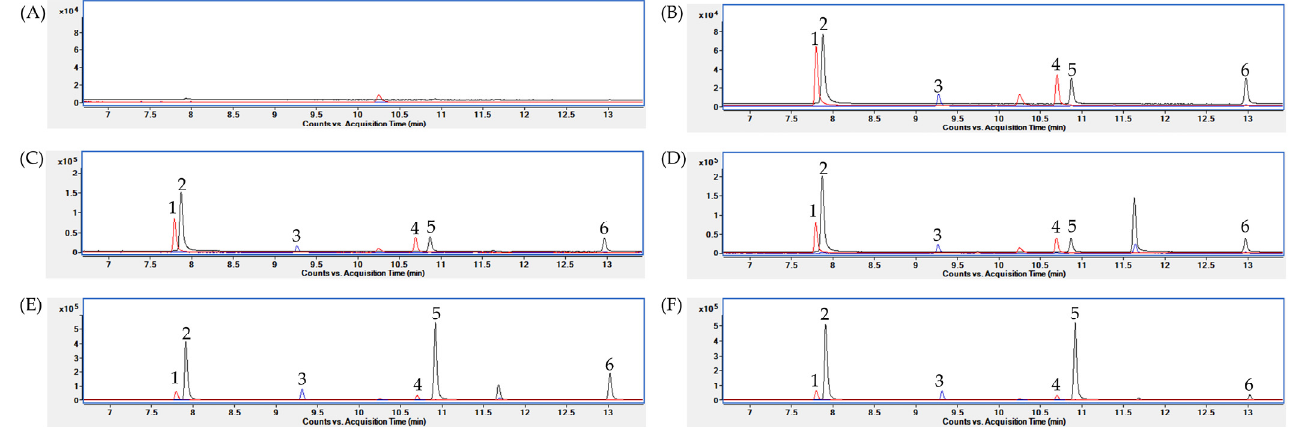
Figure 2. Aggregates of SIM chromatograms (black, m / z = 60.0; red, m / z = 63.0; blue, m / z = 74.0) of SCFAs extracted with MTBE in ( A ) blank water, ( B ) SCFA standard mixture in water, ( C ) plasma, ( D ) serum, ( E ) feces, and ( F ) mouse cecum tissue samples. Peak identification: 1, acetic acid-d 4 ; 2, acetic acid; 3, propionic acid; 4, butyric acid-d 7 ; 5, butyric acid; 6, valeric acid.